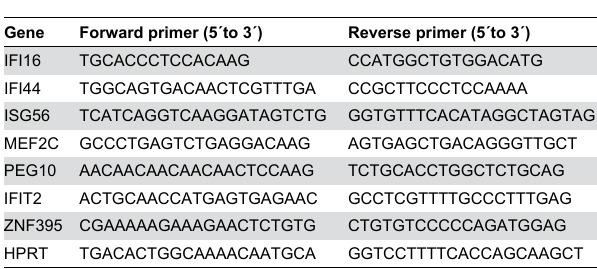
Table 1. Primers used for